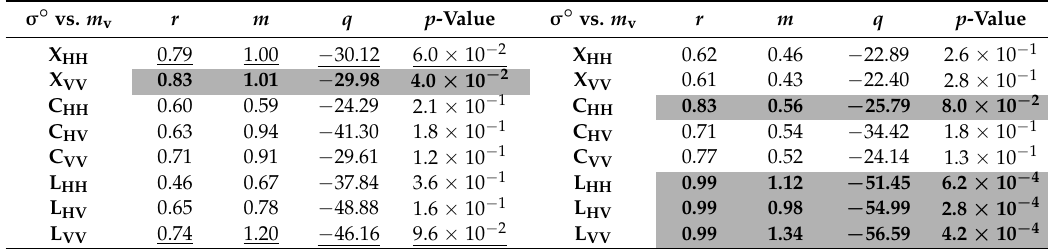
Table 3. σ ° vs. m v over bare soil for plot 460 (left panel) and plot 222 (right panel). Significant and very strong correlations (i.e., p -value less than 0.05 and r > 0.8) are highlighted in dark-grey with values in bold: quasi -significant correlations (i.e., 0.05 < p -value < 0.1) are underlined.